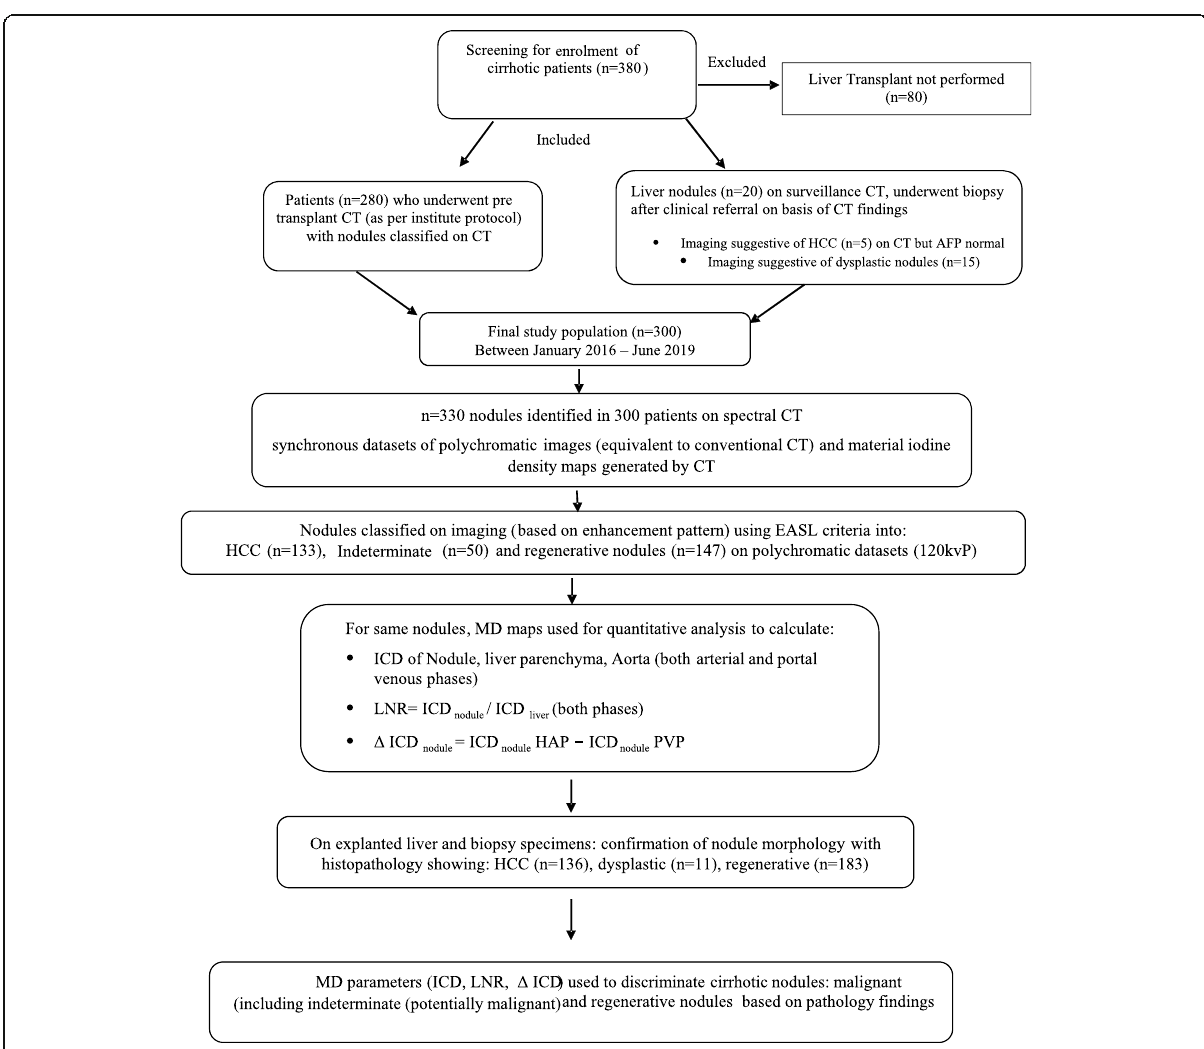
Fig. 1 Flowchart of the study design and workflow. AFP Alpha-fetoprotein, CT Computed tomography, EASL European Association for the Study of the Liver, HCC Hepatocellular carcinoma, ICD Iodine concentration density. LNR = ICD nodule /ICD liver , ICD difference of nodule ( Δ ICD nodule ) = ICD nodule HAP minus ICD nodule